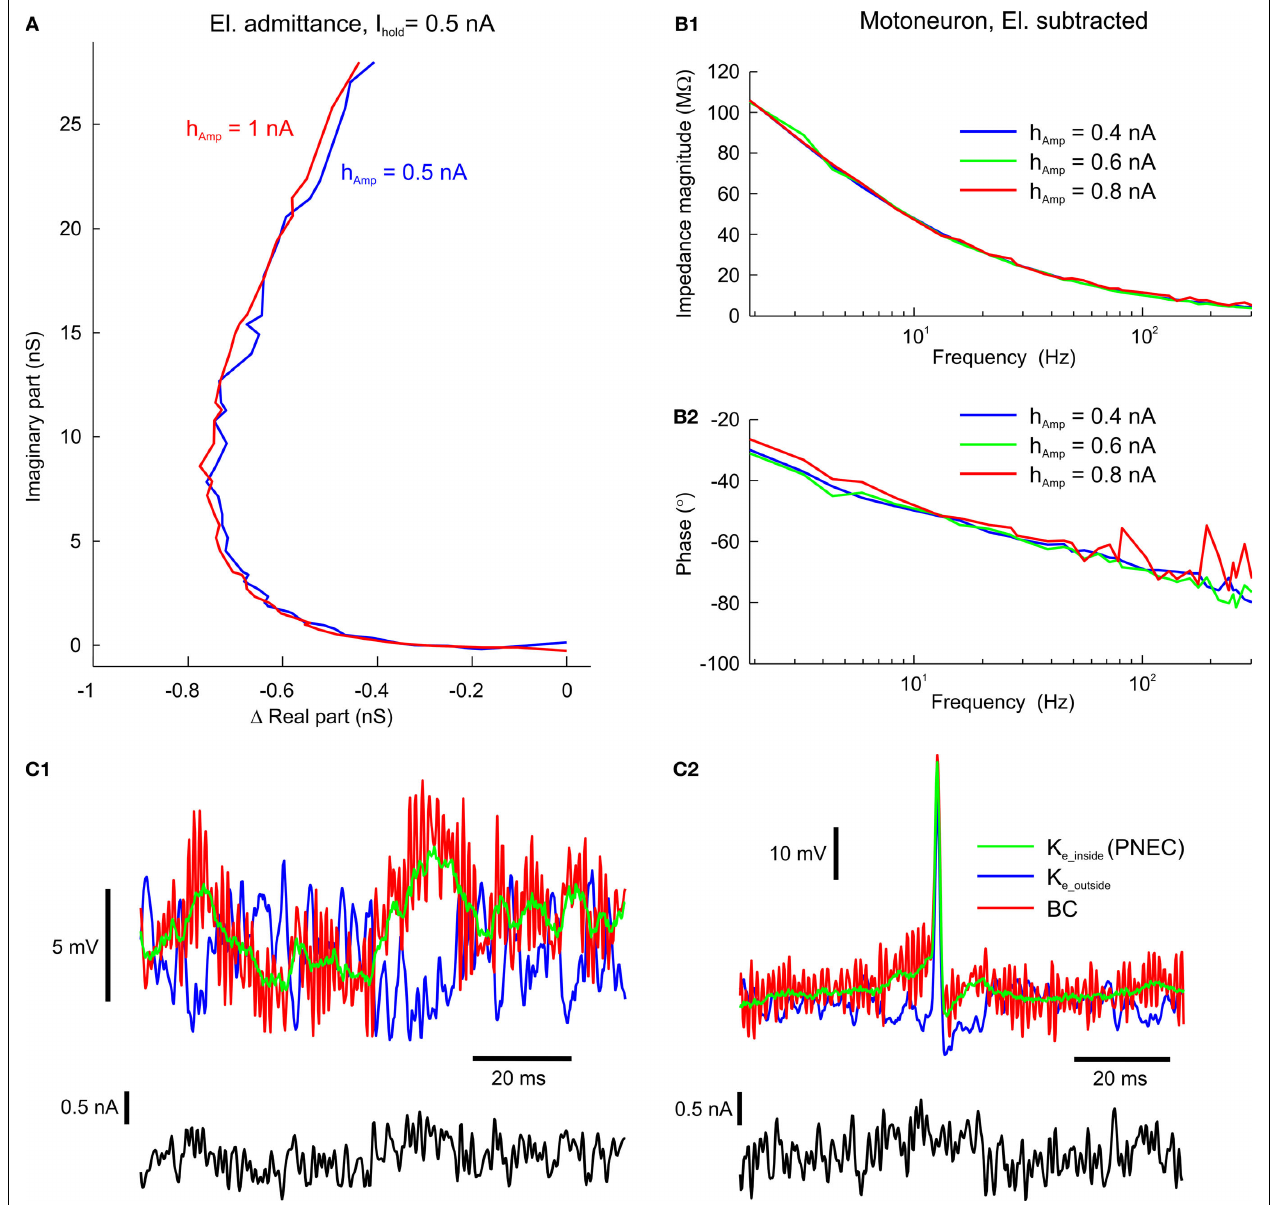
FIGURE 5 | Test of piece-wise linearity and offl ine compensation in time-domain measurements. (A) Admittance plot of the electrode properties at half peak-to-peak multi-sine current amplitudes of h and h = 1 nA (red line); real part is shown as relative conductance to correct Amp for the temporal fl uctuation; plotted frequency spectrum 0.2–625 Hz. (B1,B2) Bode plots of the impedance profi les of an AbMot at I peak-to-peak multi-sine current half amplitudes of 0.4 nA (blue lines), 0.6 nA